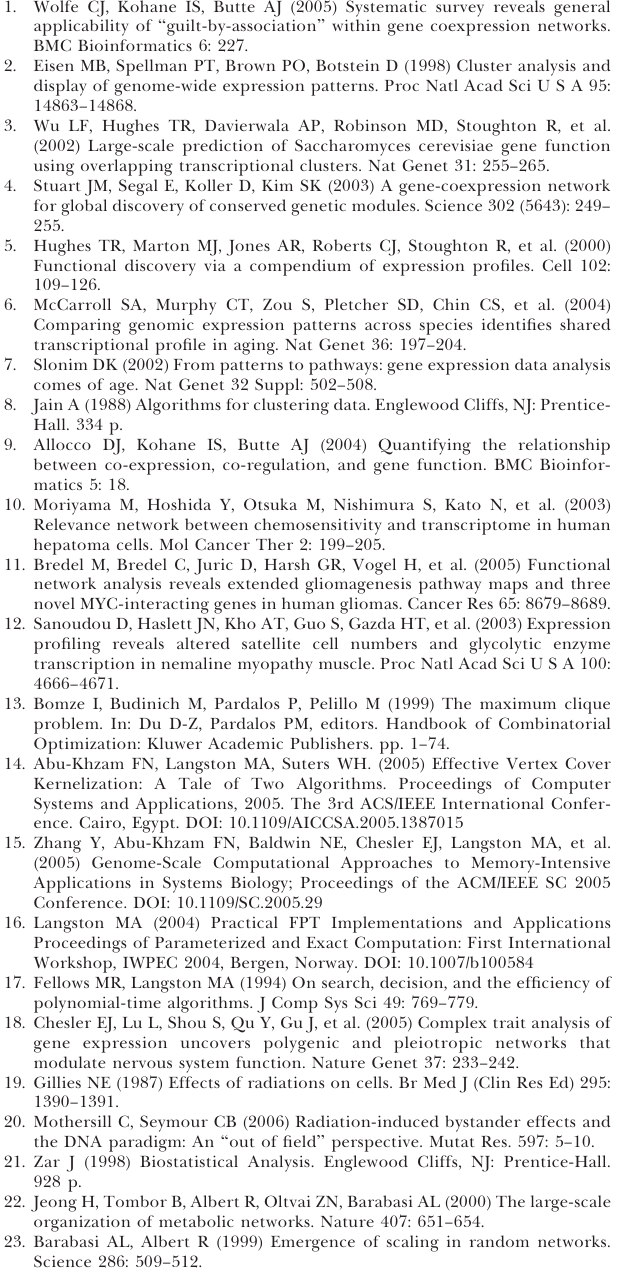
Table S1. Complete List of Genes Identified using the Triple Screen Found at DOI: 10.1371/journal.pcbi.0020089.st001 (133 KB